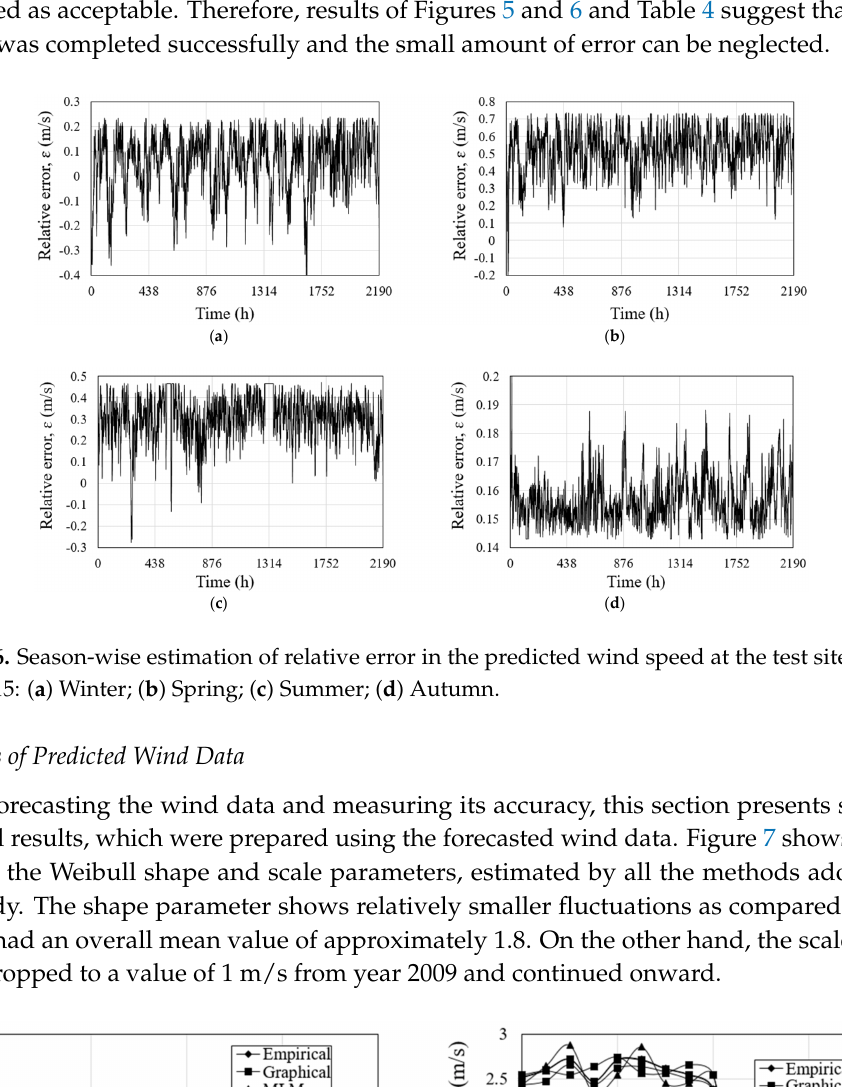
Figure 7. Estimations of the Weibull parameters at the test site using predicted data: ( a ) Shape parameter; ( b ) Scale parameter. MLM: maximum likelihood method; PD: power density.